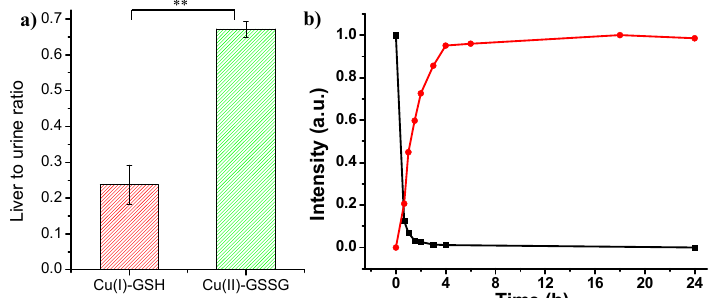
Figure 6. ( a ) Liver-to-urine ratios of Cu(I)-GSH and Cu(II)-GSSG complexes at 24 h p.i.; ( b ) Time-dependent fluorescence intensity of Cu(I)-GSH complex (black curve) and absorption intensity (625 nm) of formed Cu(II)-GSSG complex from the oxidation of Cu(I)-GSH complex (red curve). (“**”, significance of difference).